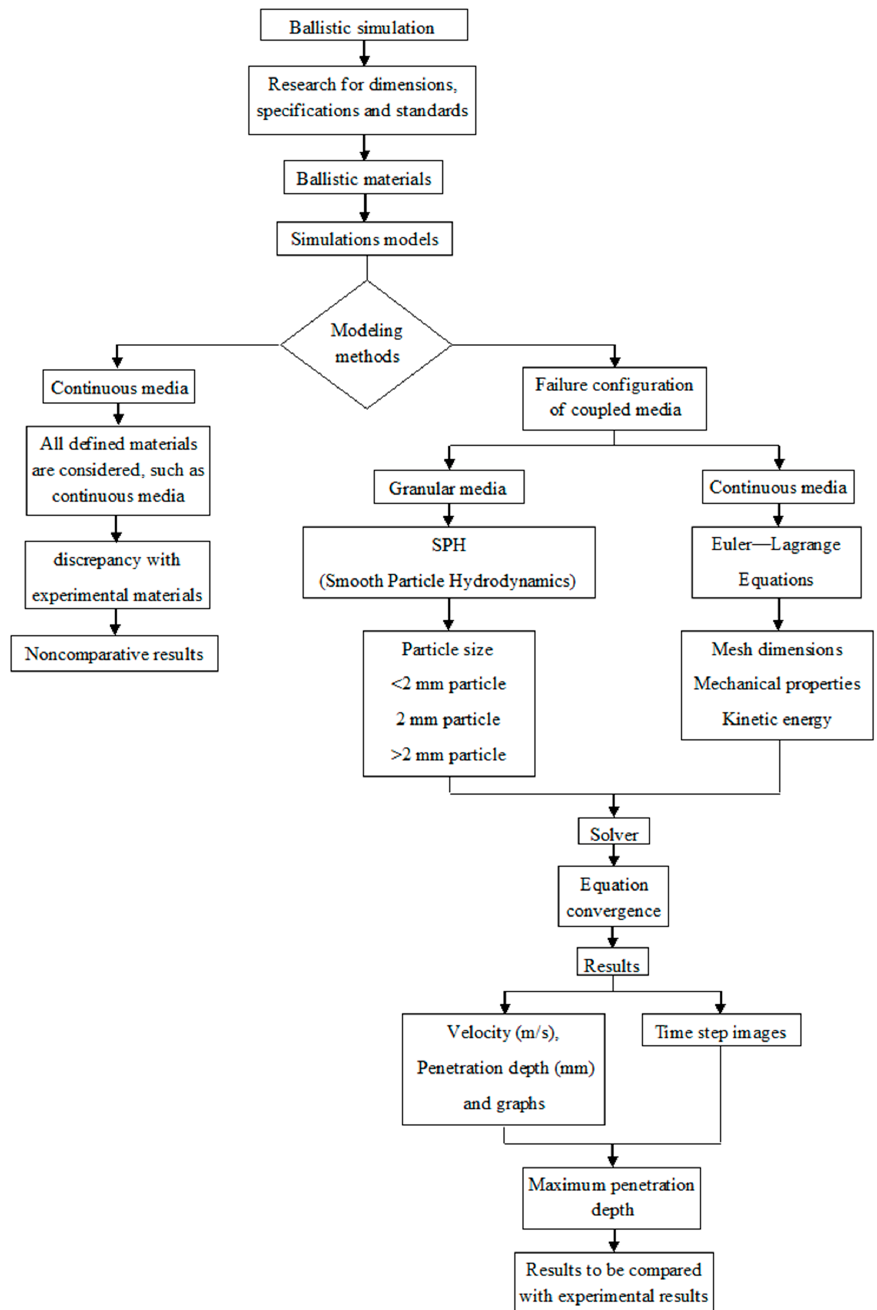
Figure 4. Simulation process flowchart.